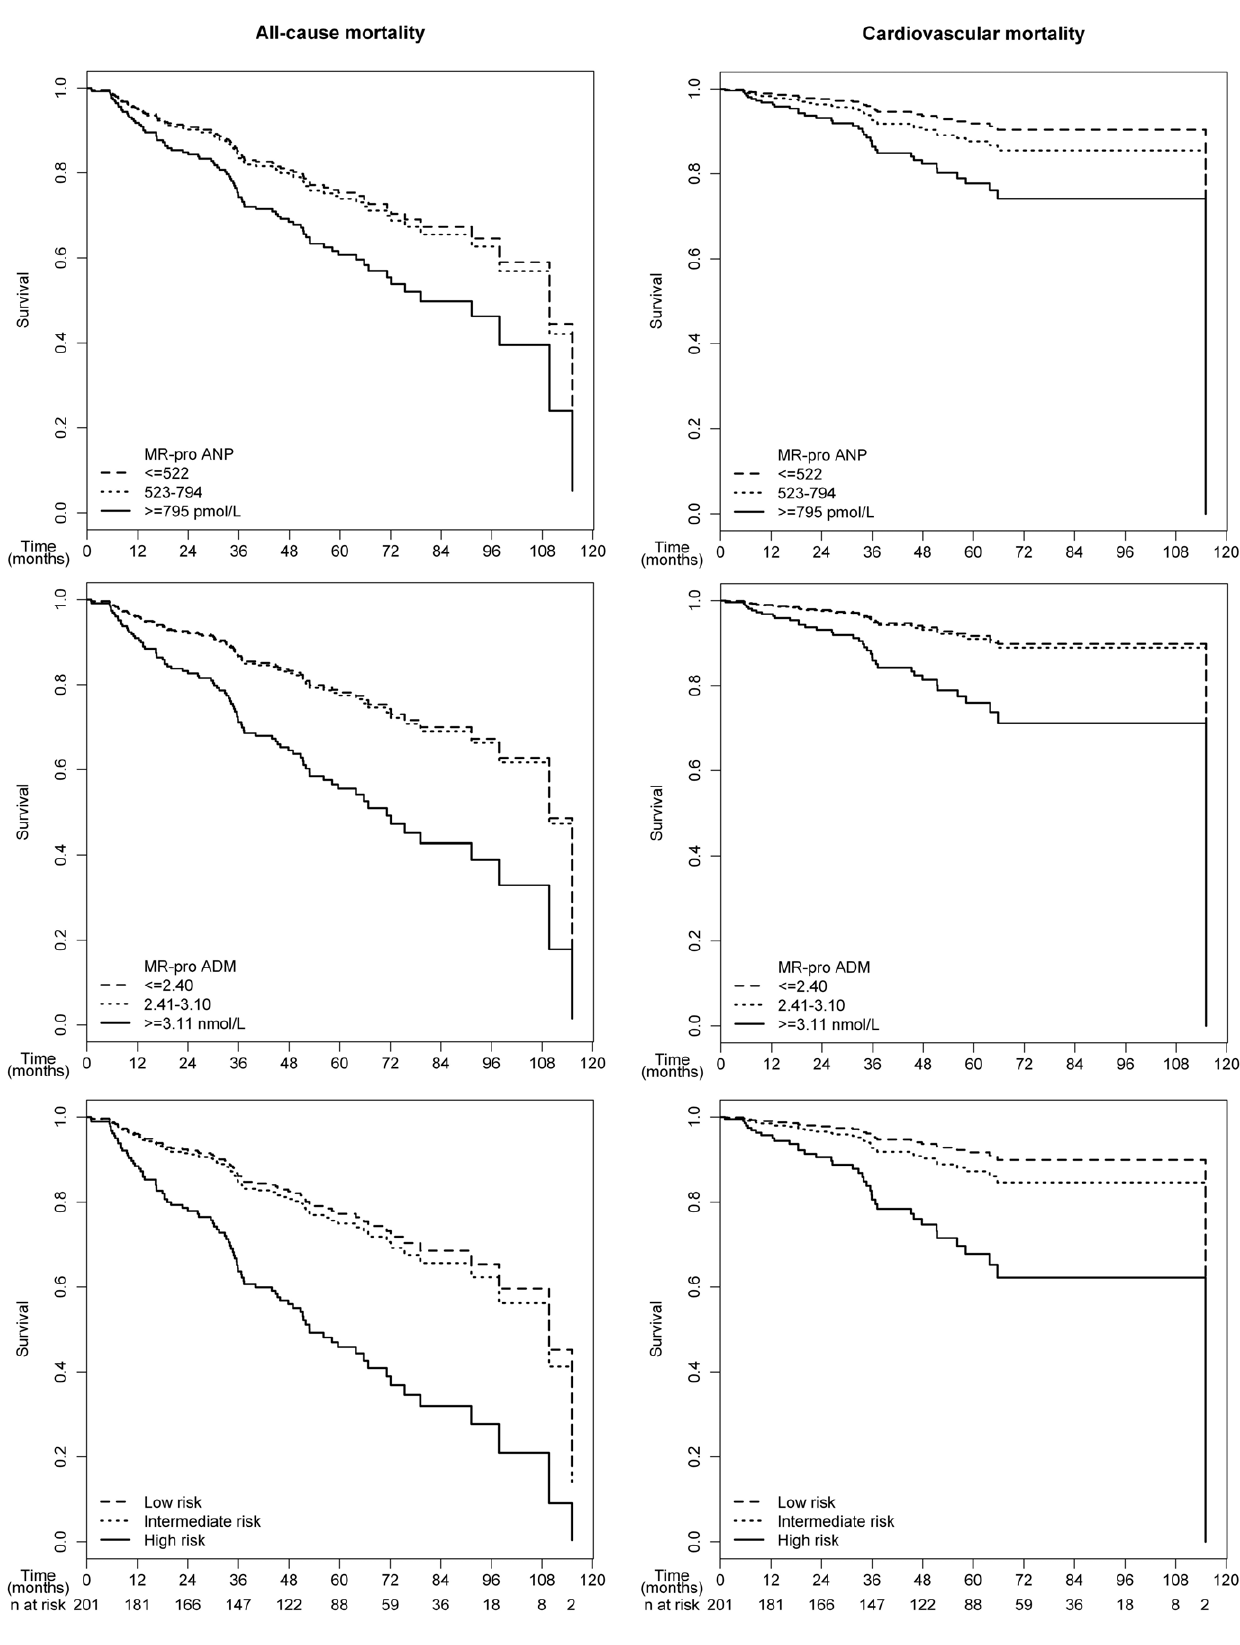
Figure 2. Survival curves for all-cause and cardiovascular mortality adjusted for age, sex, previous cardiovascular events, diabetes mellitus and time-dependent type of renal replacement therapy for mid-regional pro-atrial natriuretic peptide (MR-proANP)